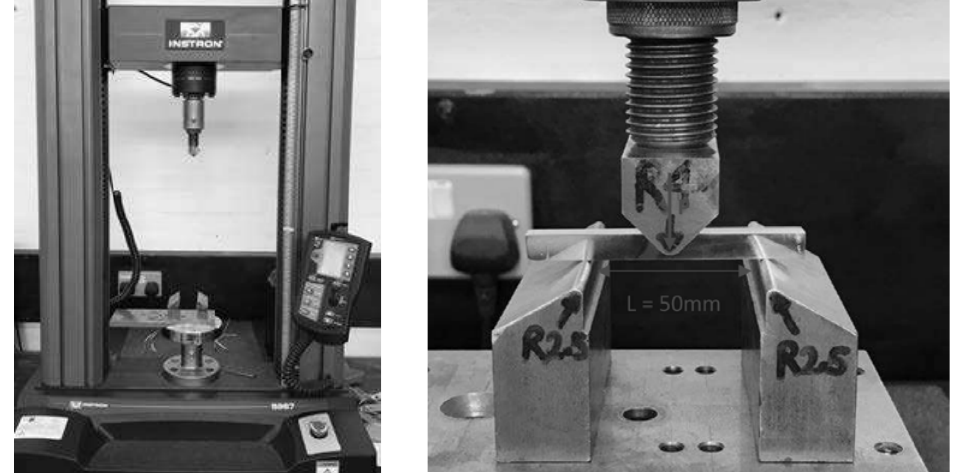
Figure 6. Details of the three-point flexure test performed in this research.